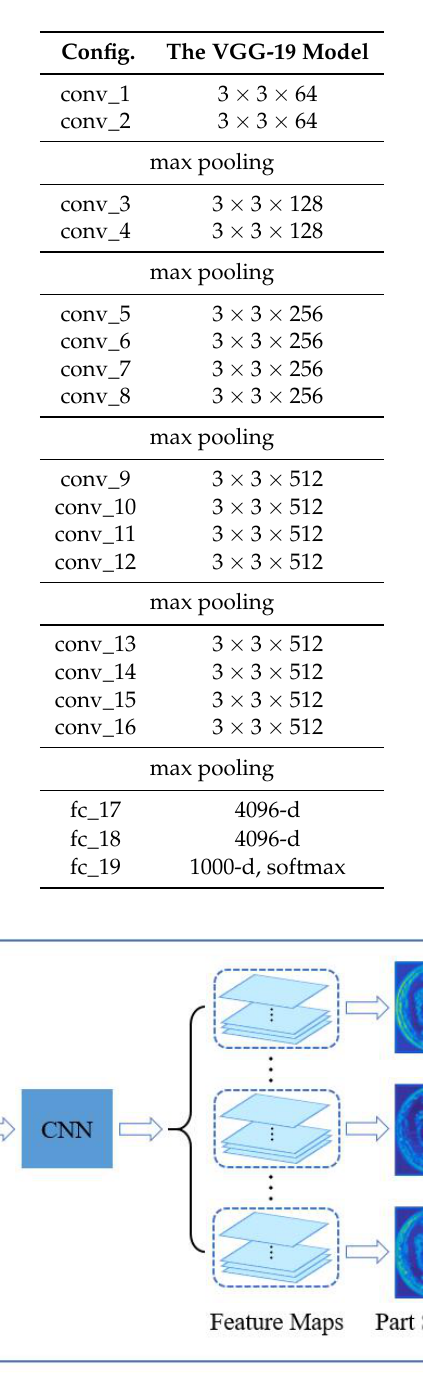
Table 1. The configuration of the VGG-19 model. con_ i denotes the i -th convolutional layer, and the convolution stride is set to 1 pixel. Max pooling is implemented by a sliding window of 2 × 2 pixels with stride 2.